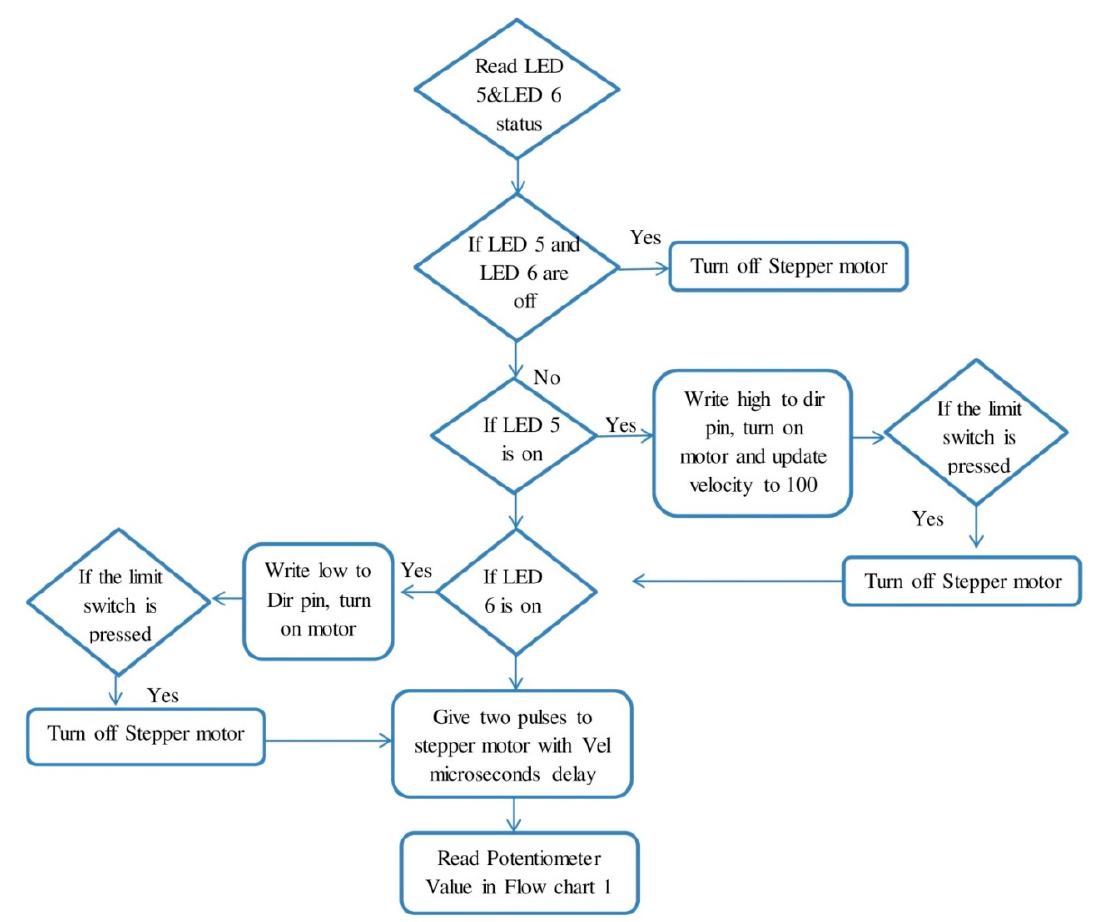
Figure 4. Flow chart of the Arduino program to control the movements of machines through stepper motor.